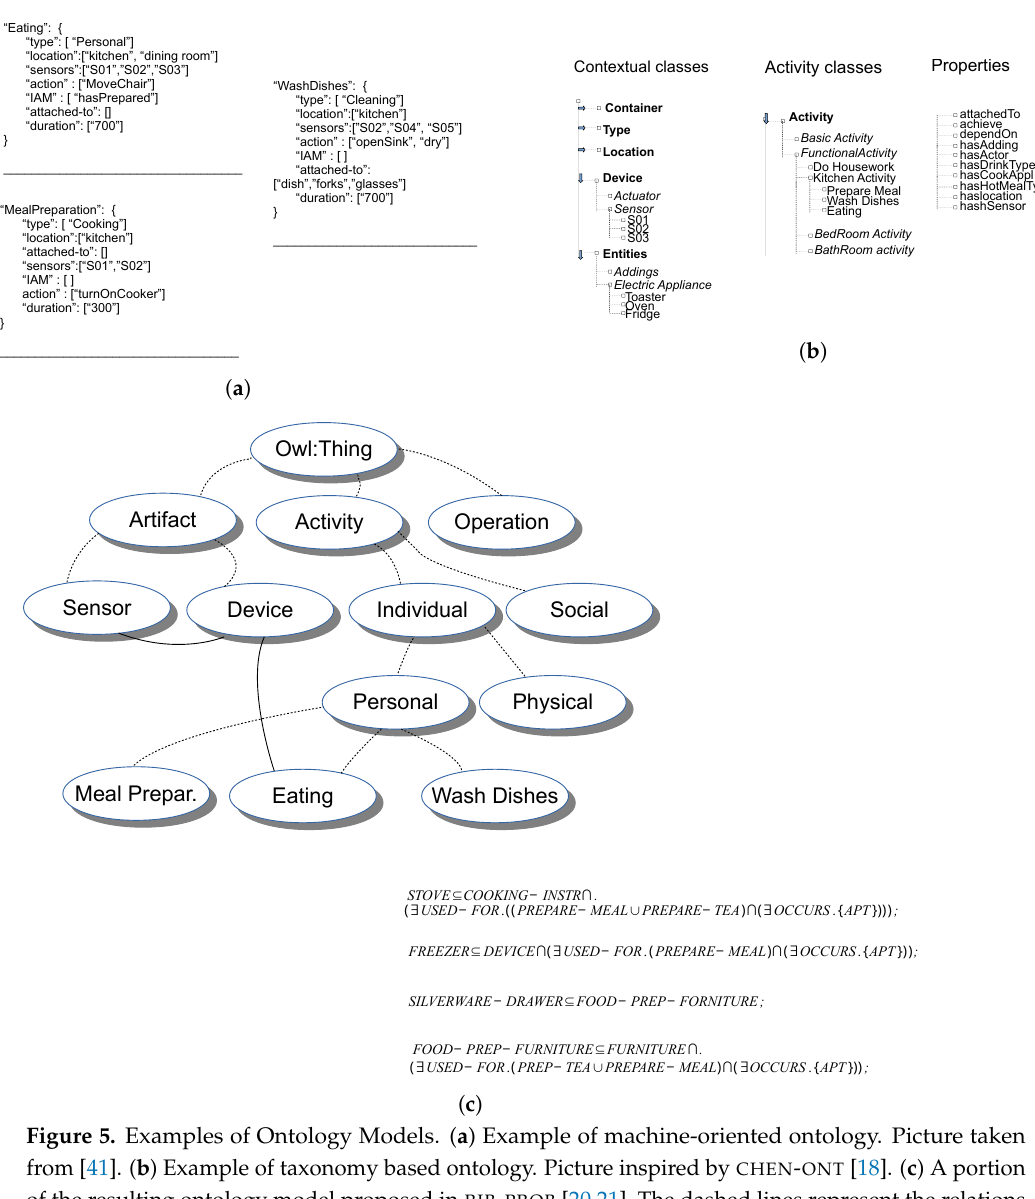
Figure 5. Examples of Ontology Models. ( a ) Example of machine-oriented ontology. Picture taken from [41]. ( b ) Example of taxonomy based ontology. Picture inspired by CHEN - ONT [18]. ( c ) A portion of the resulting ontology model proposed in RIB - PROB [20,21]. The dashed lines represent the relations super/sub between